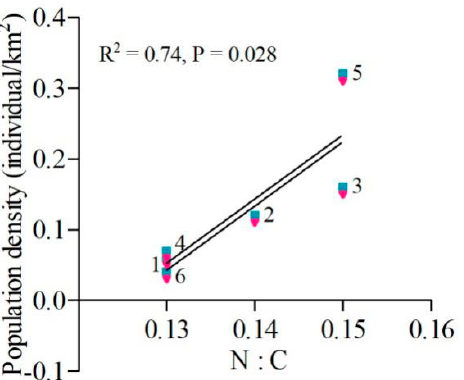
Figure 4. The linear relationship (solid line, R 2 = 0.74, p = 0.028) between N:C (protein intake:TNC intake) and population density in both female (red) and male (blue) moose (male values were shifted +0.01 vertically to make them visible) at Mohe ( 1 ), Nanwenghe ( 2 ), Zhanhe ( 3 ), Shuanghe ( 4 ), Hanma ( 5 ), and Meitian ( 6 ).